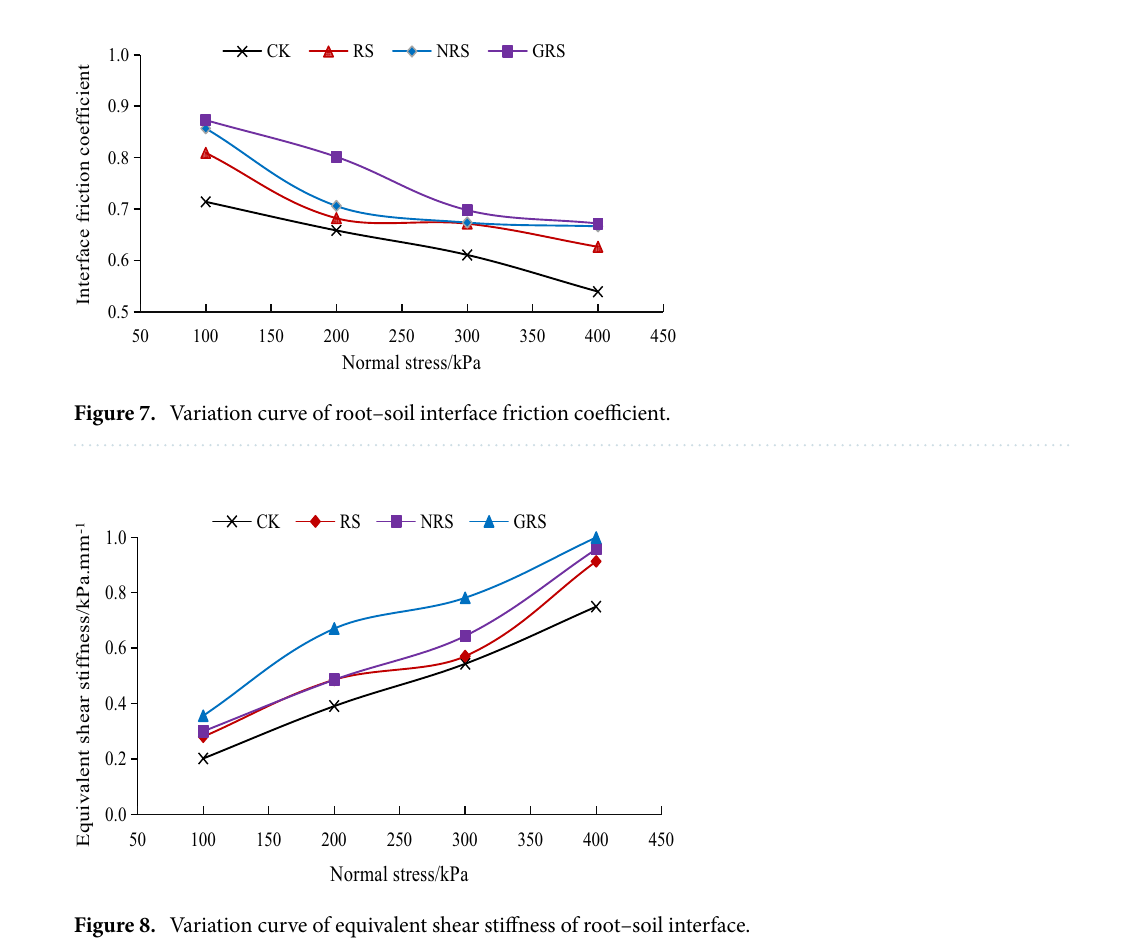
Interface friction coefficient. Figure 7 shows the variation curve of the friction coefficient at the interface of the A. fruticosa root and tailings soil. Under different conditions of interfacial bond strength, the interfacial friction coefficients of A. fruticosa root–tailed sandy soil were all greater than those of bare tailings soil, increasing from 3.62 to 24.54%. This shows that the root–soil interface bonding strength can effectively increase the friction coef- ficient between A. fruticosa root and tailings soil.